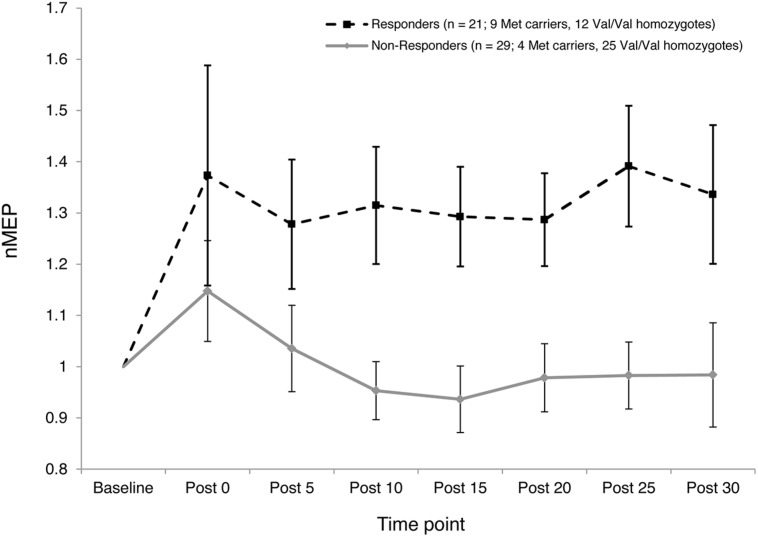
Inter-subject variability in response to atDCS. Normalized MEP amplitude (ordinate) averaged over both 10 and 20 min atDCS durations plotted at every post stimulation time point (abscissa) for each cluster (Responders – Dashed line with square markers; Non-responders – Solid line with diamond markers). nMEP > 1 represents facilitation, nMEP < 1 indicates suppression. Error bars at each time point display 95% confidence intervals around the mean.